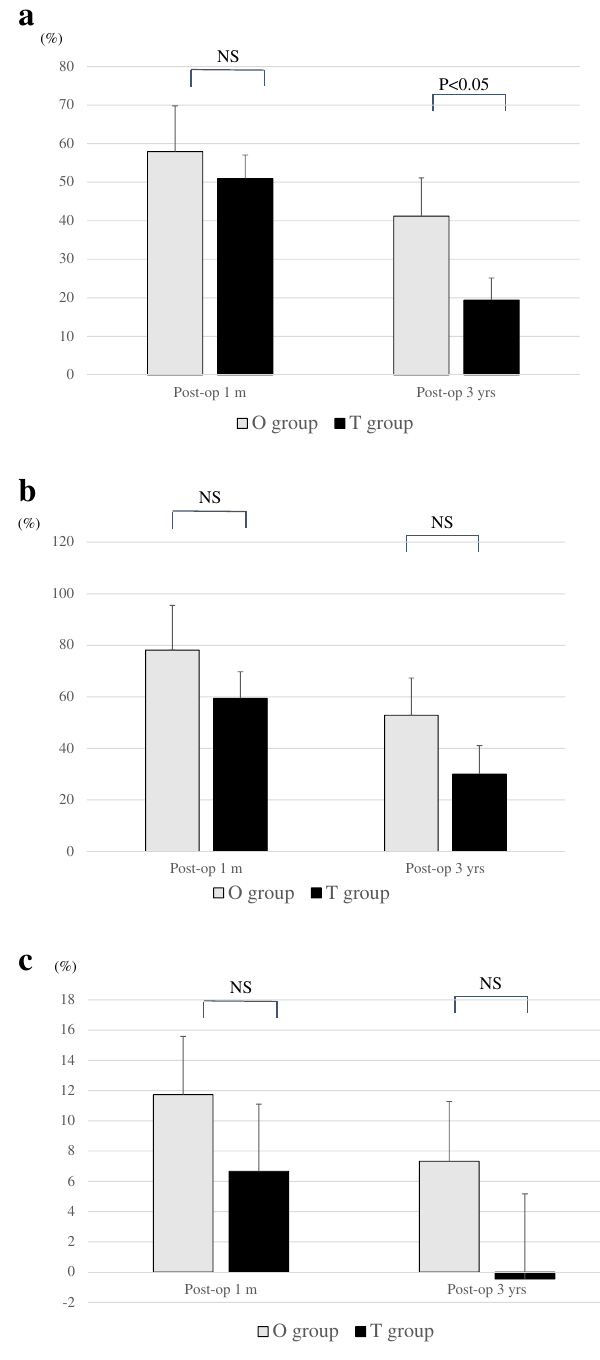
Figure 3. ( a ) Improvement rate of anterior disc height. The rate of improvement in the anterior intervertebral disc height was significantly higher in the O group. ( b ) Improvement rate of posterior disc height. ( c ) Improvement rate of segmental focal angle. There was no significant difference in the posterior disc height and rate of improvement between the O and T groups at one month postoperatively and at the final evaluation. Abbreviations: T group, patients who underwent single-level transforaminal lumbar interbody fusion; O group, patients who underwent single-level oblique lateral interbody